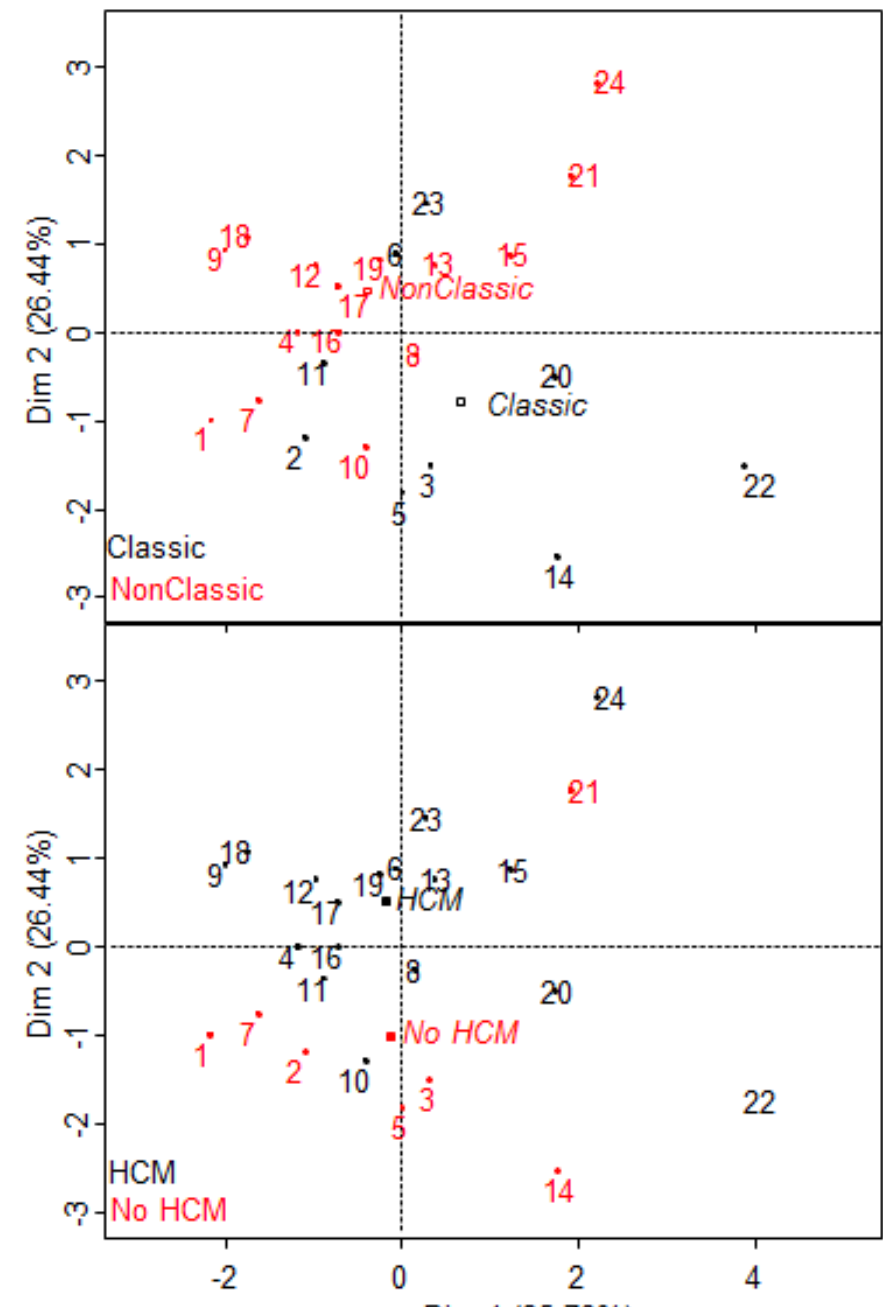
Figure 3. Individuals and qualitative factor map of principal component analysis including S1P, lysoGb3, FGF2, VEGF-A, VEGF-C, and IL-7 as active variables. Phenotype (Classic or Non-classic) (upper) and hypertrophic cardiomyopathy (HCM) (lower) are included as illustrative variables.